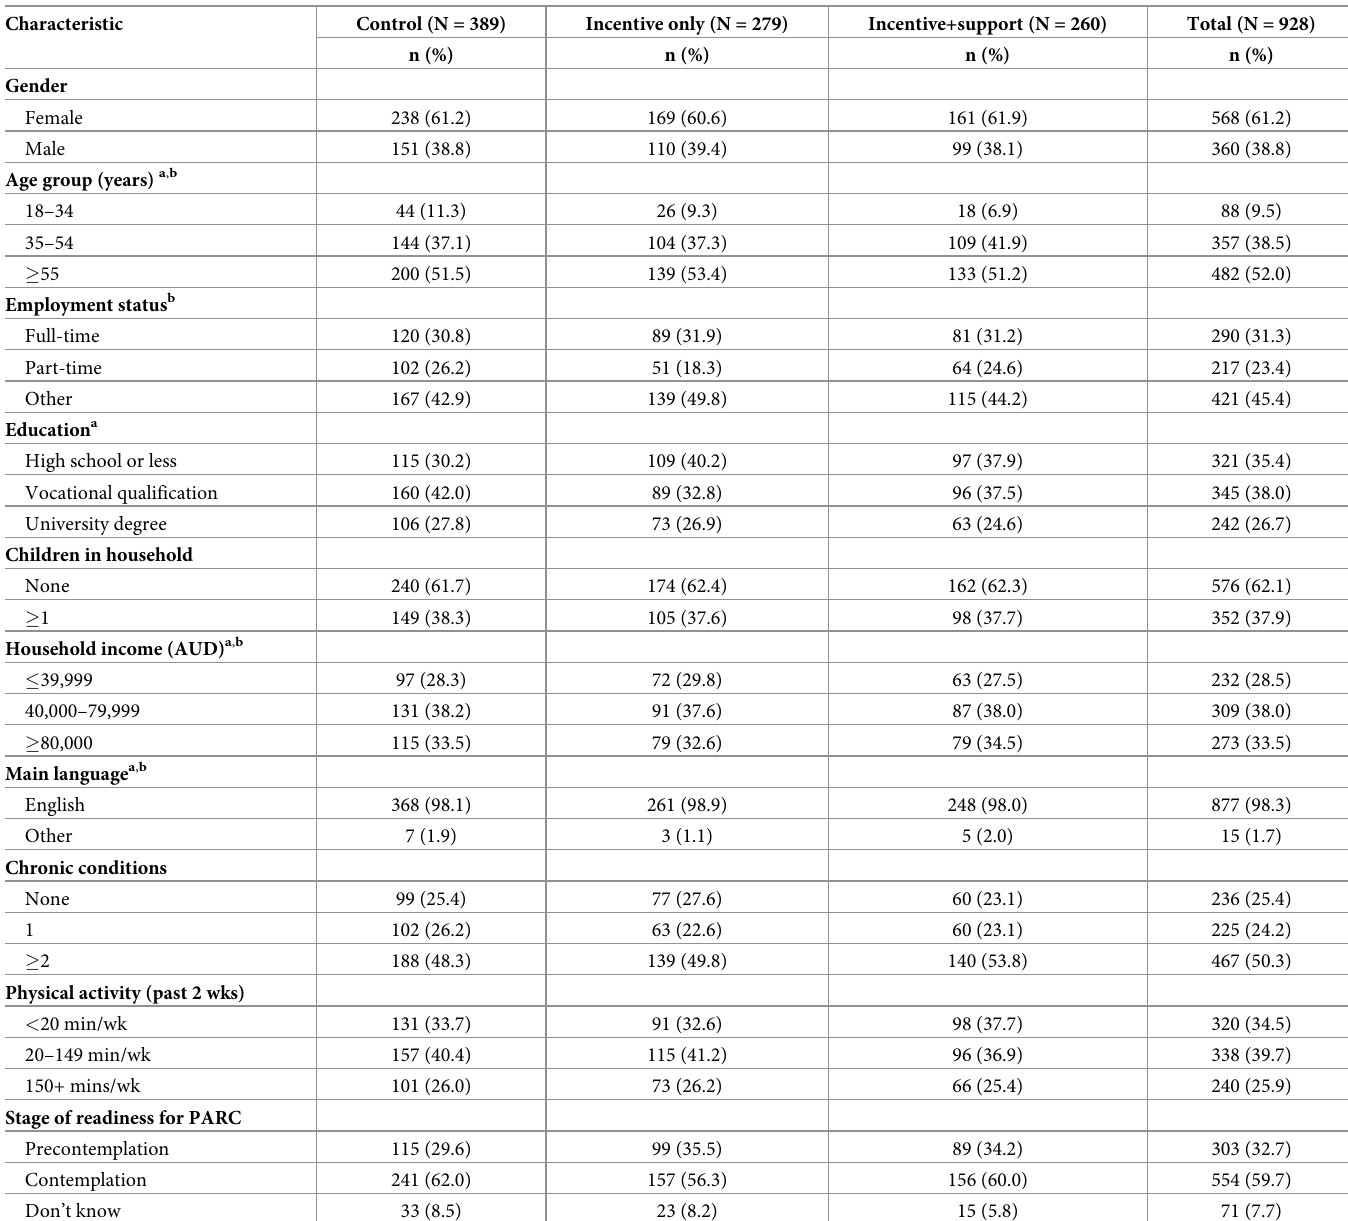
Table 1. Characteristics of participants at 12 months